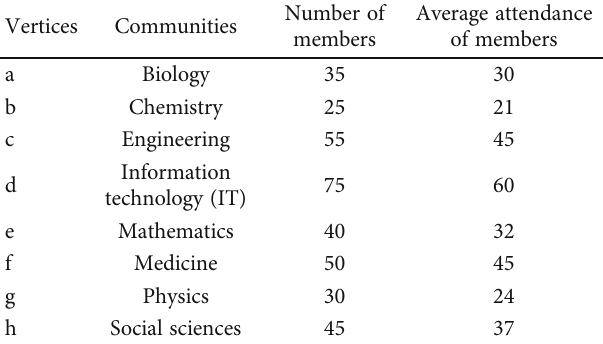
Table 8: Data set. Table 9: The IVIFNs of scienti fi c